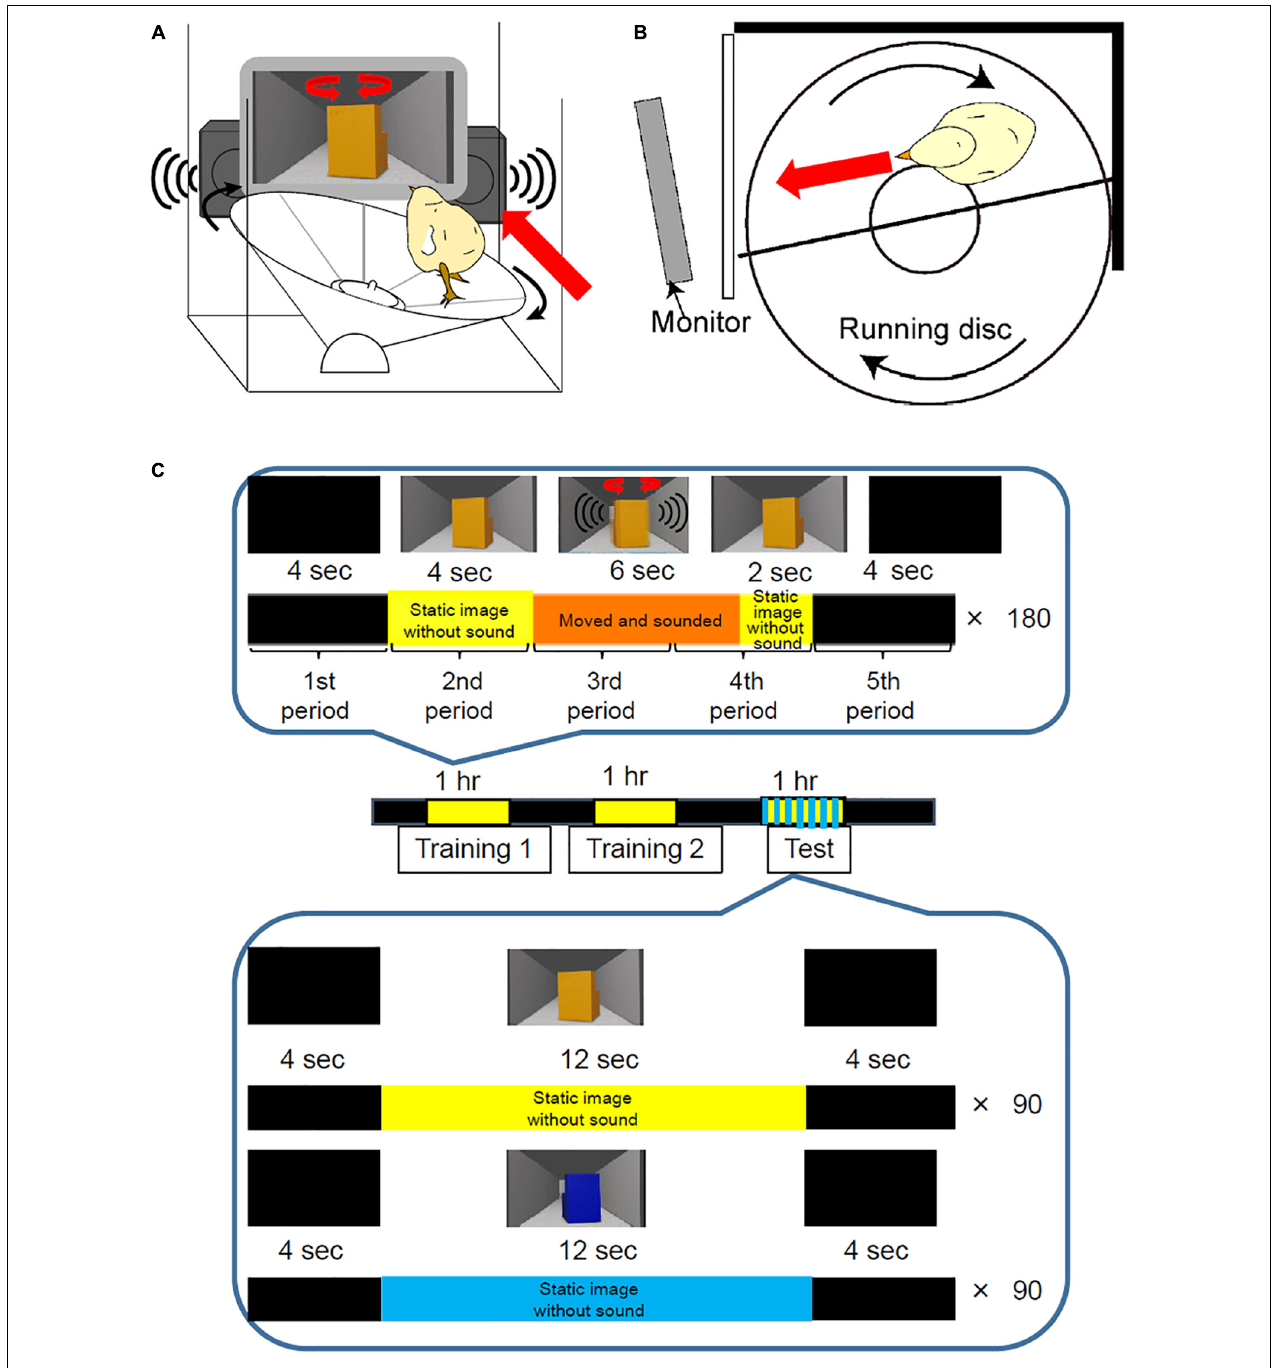
FIGURE 1 | Disc-based behavioral apparatus and procedure for imprinting training and test. (A) The running disc-based behavioral apparatus. An imprinting object was shown through a TFT monitor which was placed in front of the apparatus. Artificial sounds were played through the speakers. (B) A top view of the running disc-based behavioral apparatus. The chick is surrounded by the black-colored walls made from acrylic boards or thin paper. The front wall is transparent to make the chick see the movie on the monitor. The chick represented the initial position of the behavioral experiment. (C) Imprinting training and testing using the disc-based apparatus. During training, two sessions were conducted at 1 h intervals. In one session of training, a movie, 20 s long, was repeatedly played on the monitor 180 times for 1 h. In the training movie, a yellow imprinting object appeared for 12 s. The object was static for the first 4 s, then turned clockwise and anti-clockwise repeatedly with artificial sounds for 6 s. After the object stopped, it remained static again for the last 2 s. During the interval, the monitor presented a black screen. To analyze the chicks’ performance during training, one trial of 20 s was divided into five periods (4 s each). In the preference test, two types of movies of 20 s were played pseudo-randomly for 1 h. In one movie, the yellow imprinting object appeared for 12 s and remained static without making a sound. In the remaining 8 s, the monitor presented a black screen. In another movie, a blue control object appeared for 12 s and remained static without sound.